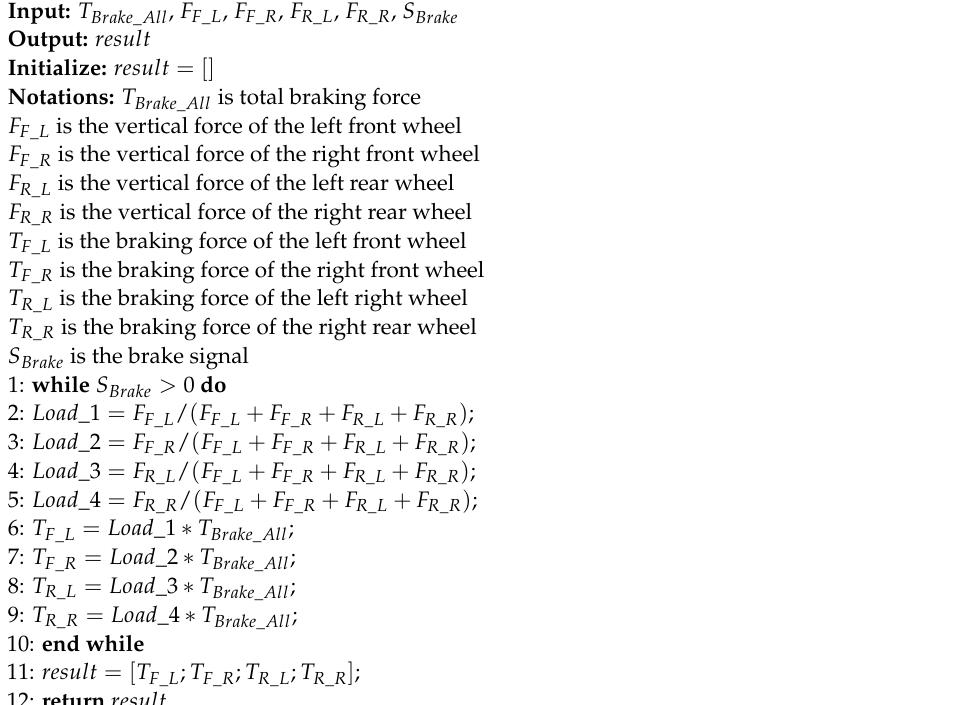
Algorithm 1 Online control algorithm of braking force distribution